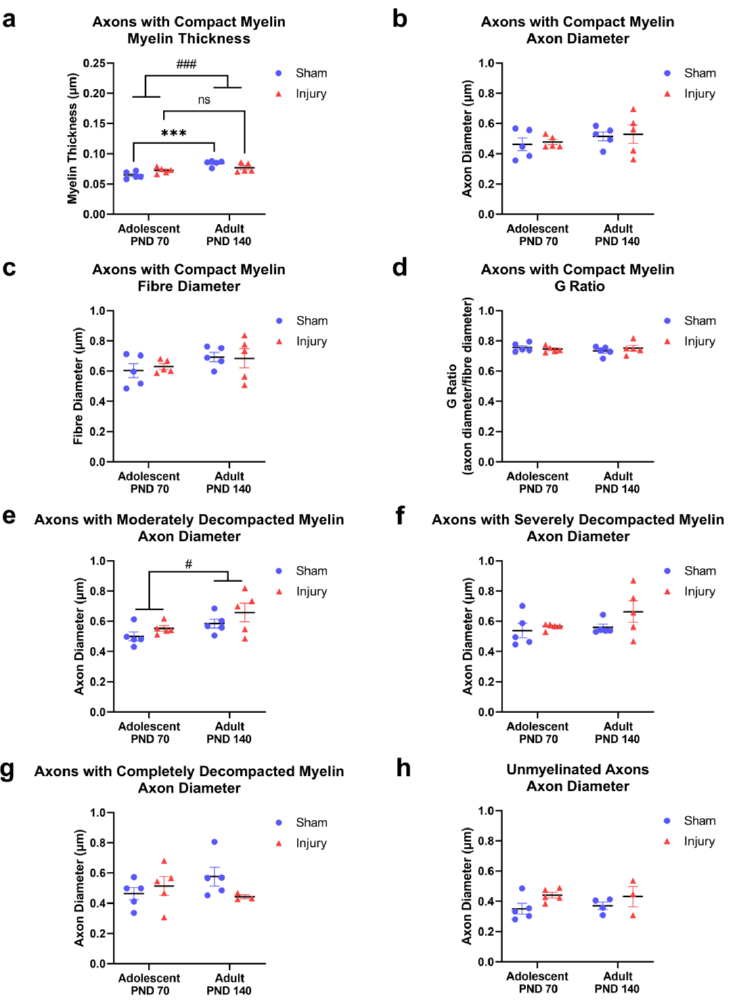
Figure 4. Morphology measurements of axons with compact myelin and diameter measurements of axons with decompacted myelin in sham and injured rats at adolescence (PND 70) and adulthood (PND 140) . In axons with compact myelin, the following morphological features were quantified by length (µm) then averaged at the level of animal and compared across groups ( n = 5): myelin thickness ( a ); axon diameter ( b ); fiber diameter ( c ); G ratio ( d ). In axons with myelin decompaction or no myelin, axon diameter was quantified by length (µm) then averaged at the level of the animal and compared across groups ( n = 5, but n = 4 and n = 3 in panel h for PND 140 groups) and displayed for the following axon classifications: axons with moderately decompacted myelin ( e ); axons with severely decompacted myelin ( f ); axons with completely decompacted myelin ( g ); unmyelinated axons ( h ). Data were presented as means ± SEM. Statistical comparisons were made between groups. ### indicate main effect p < 0.001; # p < 0.05. *** indicate post hoc comparison p < 0.001. ns indicate not significant.